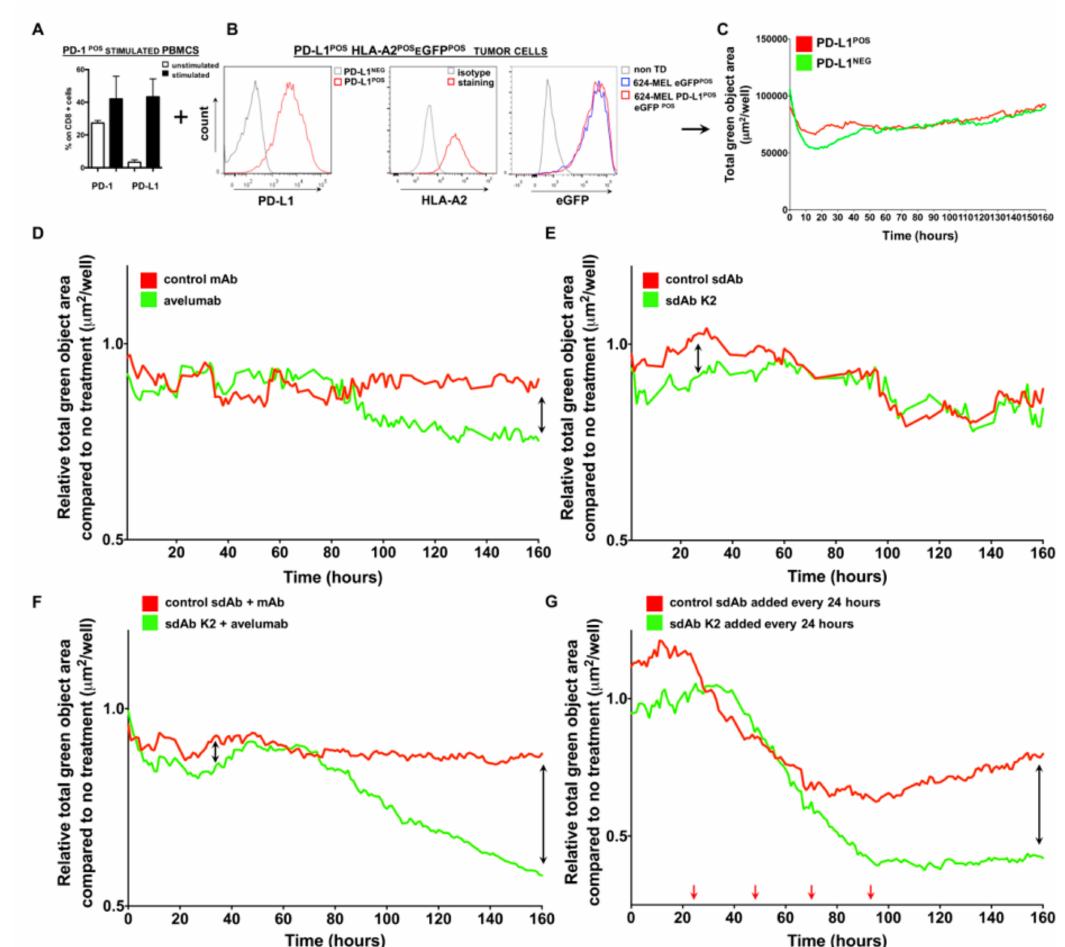
Figure 7. sdAb K2 and avelumab show in vitro therapeutic e ffi cacy, albeit with di ff erent kinetics. ( A – C ) Schematic representation of the experimental setup. ( A ) Bar graph showing the percentage of PD-1 or PD-L1 expression on CD8 POS T cells present within unstimulated PBMCs (white bars) or PBMCs stimulated with anti-CD3 mAb and IL-2 (black bars). The mean ± SEM are shown ( n = 3). ( B ) Representative histograms showing expression of PD-L1, HLA-A2 and eGFP by engineered 624-MEL cells ( n = 3). ( C ) Activated PBMCs were added to HLA-A2 POS , eGFP POS and PD-L1 POS 624-MEL cells or to HLA-A2 POS , eGFP POS and PD-L1 NEG 624-MEL cells that were grown in 3D spheroids. The total green object area ( µ m2 / well), representing viable tumor cells, was measured every hour for seven constitutive days using the IncuCyte Zoom ® live cell imaging system and is shown in the graph ( n = 3). ( D – G ) Activated PBMCs were added to HLA-A2 POS , eGFP POS and PD-L1 POS 624-MEL cells that were grown in 3D spheroids in the absence or presence of PD-L1 blocking agents. The total green object area ( µ m2 / well), representing viable tumor cells, was measured every hour for seven constitutive days using the IncuCyte Zoom ® live cell imaging system and is shown in the graphs. ( D ) Tumor cell killing in the presence of 3.6 µ M avelumab (green curve) or 3.6 µ M control mAb (red curve). ( E ) Tumor cell killing in the presence of 3.6 µ M sdAb K2 (green curve) or 3.6 µ M control sdAb (red curve). ( F ) Tumor cell killing in the presence of 3.6 µ M sdAb K2 and 3.6 µ M avelumab (green curve) or 3.6 µ M control sdAb and 3.6 µ M control mAb. ( G ) Tumor cell killing when 3.6 µ M sdAb K2 (green curve) or 3.6 µ M control sdAb (red curve) is added every 24 hours (indicated with red